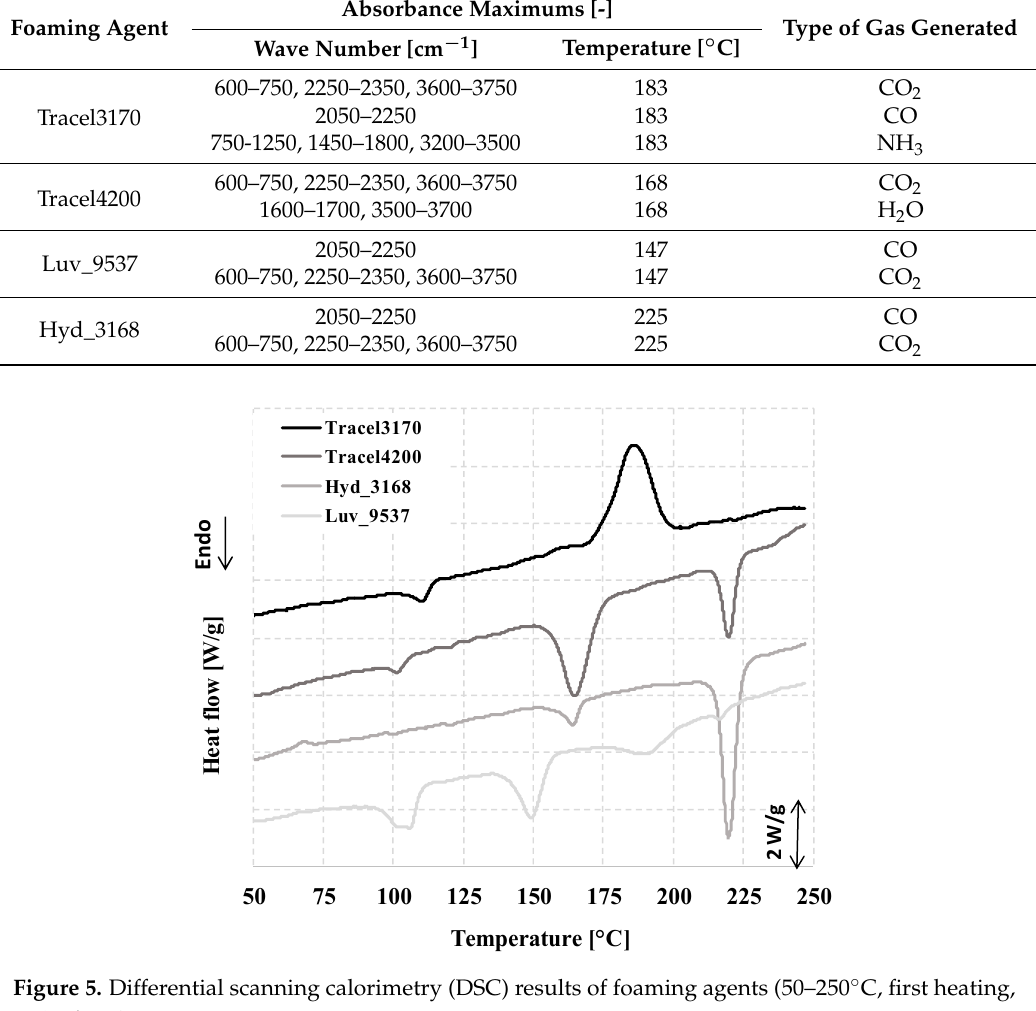
Table 3. The results of the TGA-FTIR measurement (10 °C/min, nitrogen measuring atmosphere).